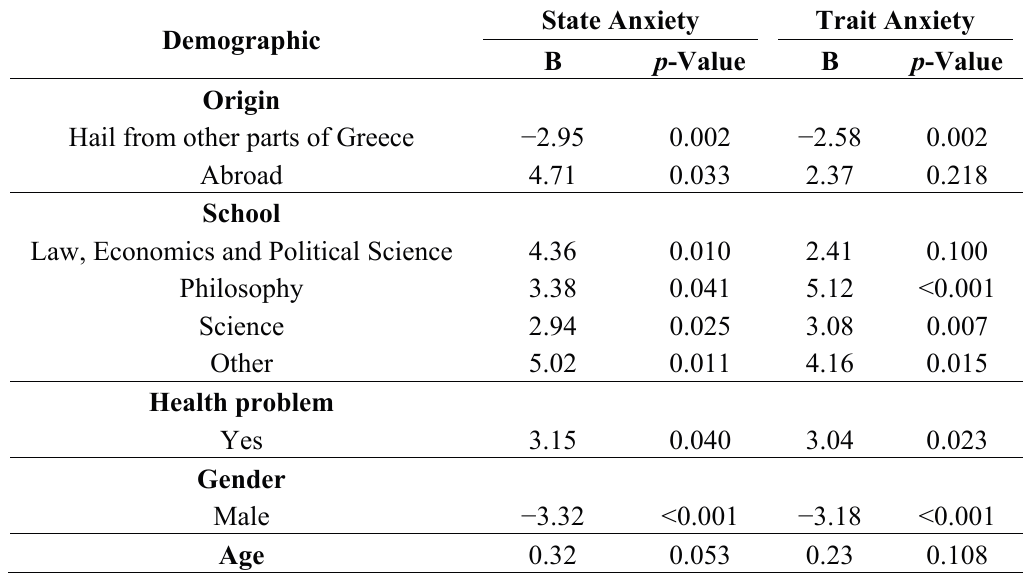
Table 4. Linear regression coefficients for State and Trait anxiety scales. State Anxiety Demographic